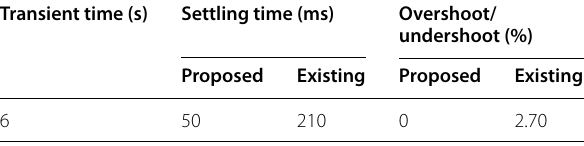
Table 4 Quantitative analysis for a wind power system